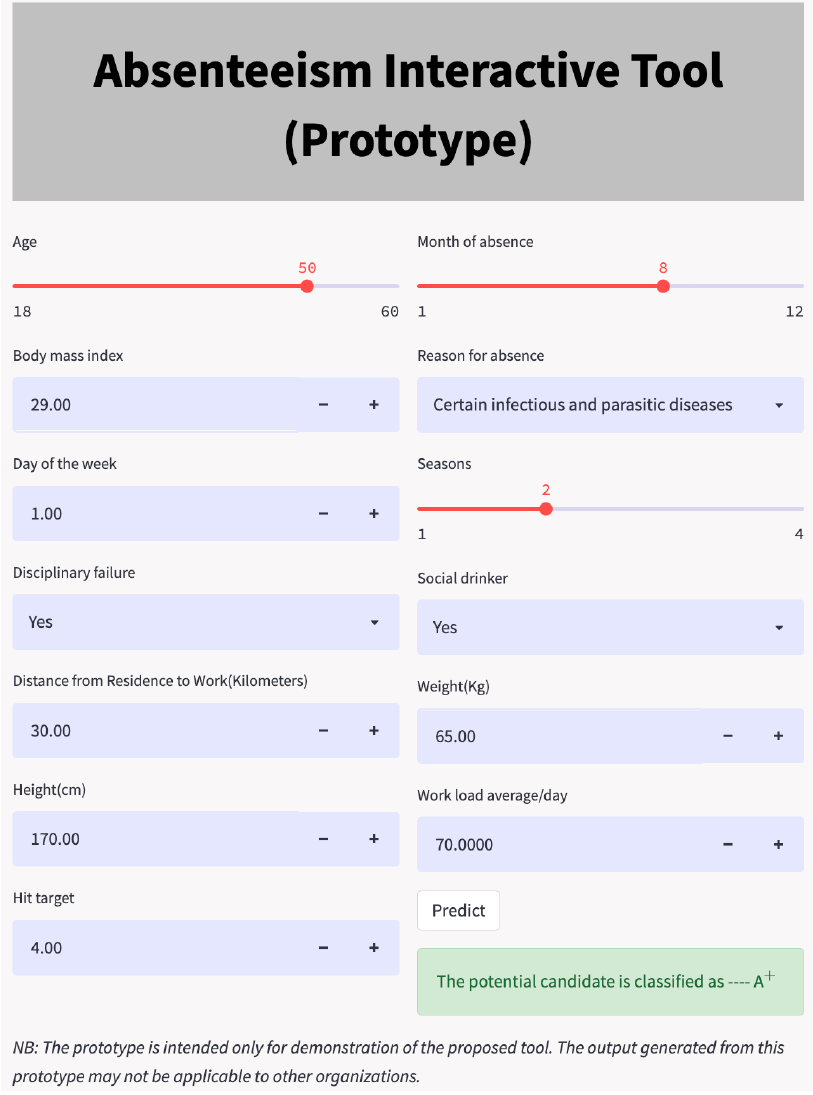
Figure 5. A screenshot of the prototype. Based on input values, the tool classifies the employee as A + on a scale of A + B + C + . The web-based tool is accessible at